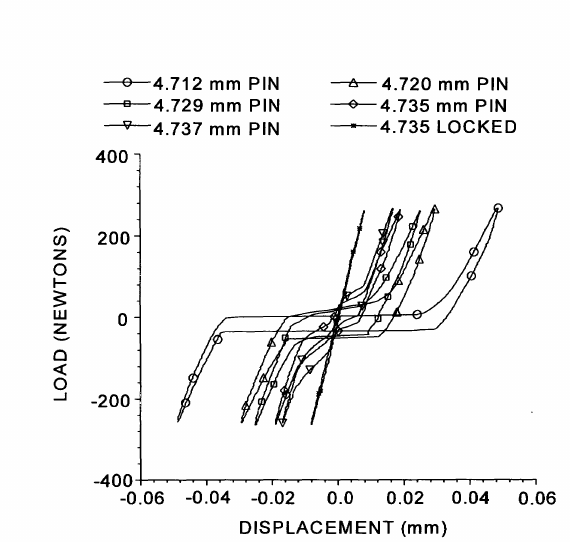
FIGURE 5 Plot of hysteresis tests for pins ranging from 4.712 to 4.737 mm diameter.